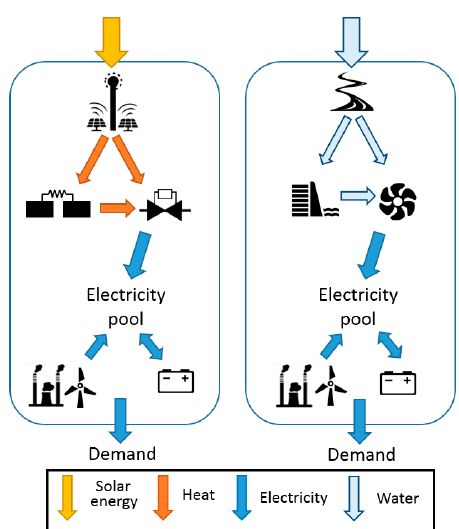
Figure 2. Scheme of the modelling of concentrated solar power (CSP) ( left ) and hydroelectric power stations ( right ) with storage.